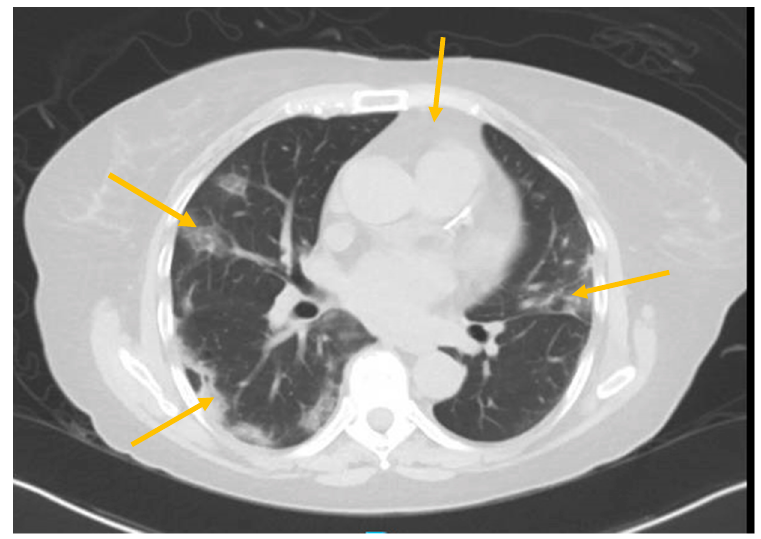
Figure 1. CT of chest showing patchy consolidations in peripheral distribution and pericardial effusion (arrows).